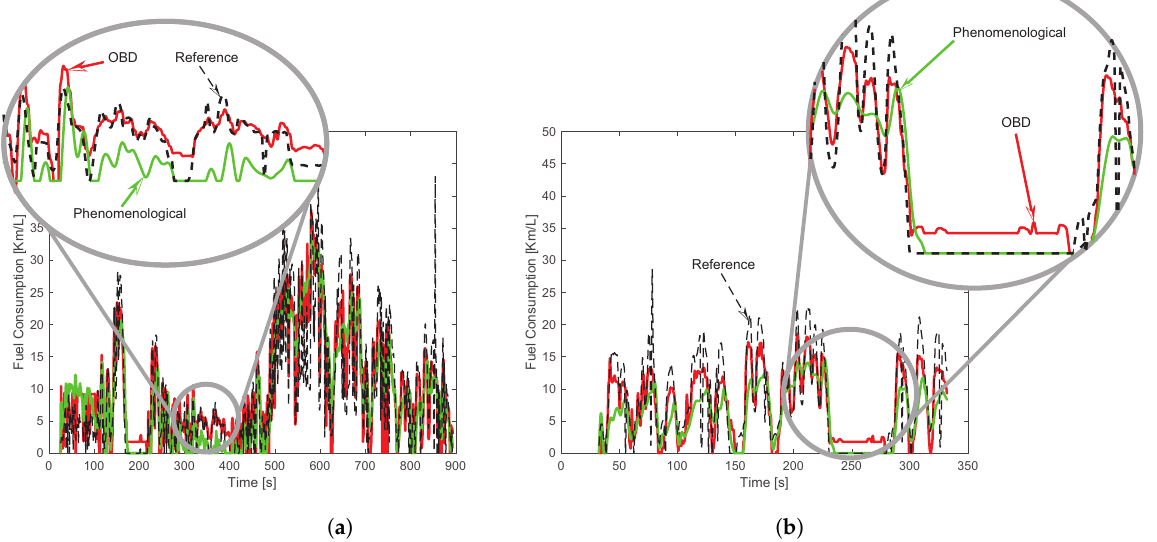
Figure 9. Fuel consumption algorithm comparison in the experiment 12 ( a ) and experiment 24 ( b ). According to the ESR index, in general, the OBD signal-based algorithm has less error variance (33.53%) than the phenomenological model (77.11%). In addition, the RRMSE index is lower with the OBD signal-based algorithm, demonstrating that the dynamic estimation of the fuel consumption is better explained by this data-driven model. The average RRMSE index among the 44 experiments is 37.64%, with respect to 60.11% obtained by the phenomenological model. On the other hand, the RE index is better (16.07%